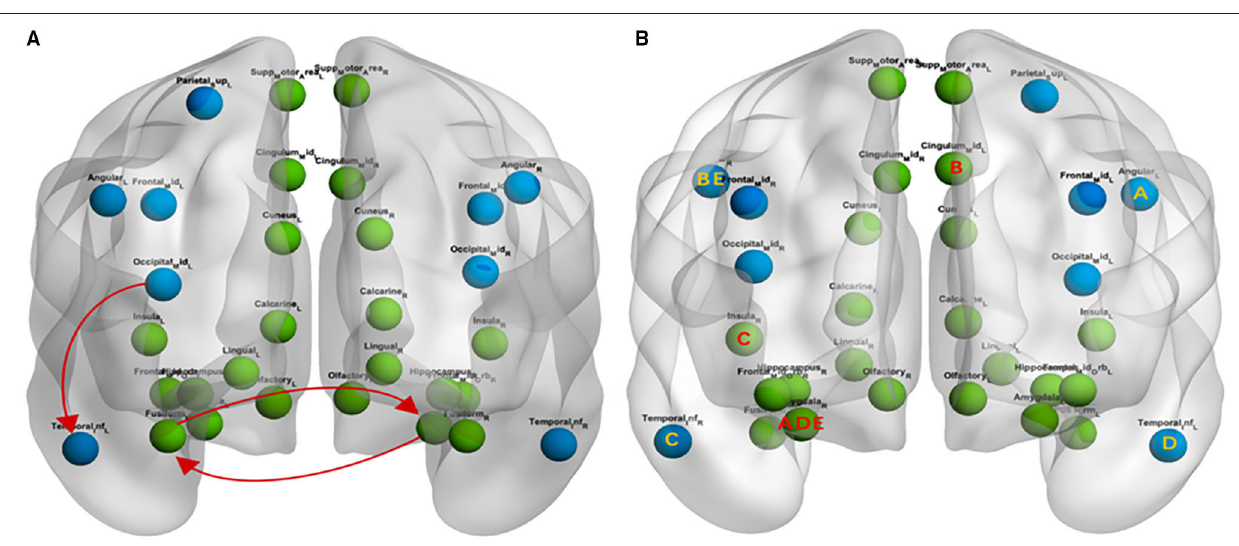
FIGURE 12 | The Change of Degree and Betweenness centrality during anesthesia recovery [blue represent the cortical area, green represent deep area; (A) Degree; (B) Betweenness